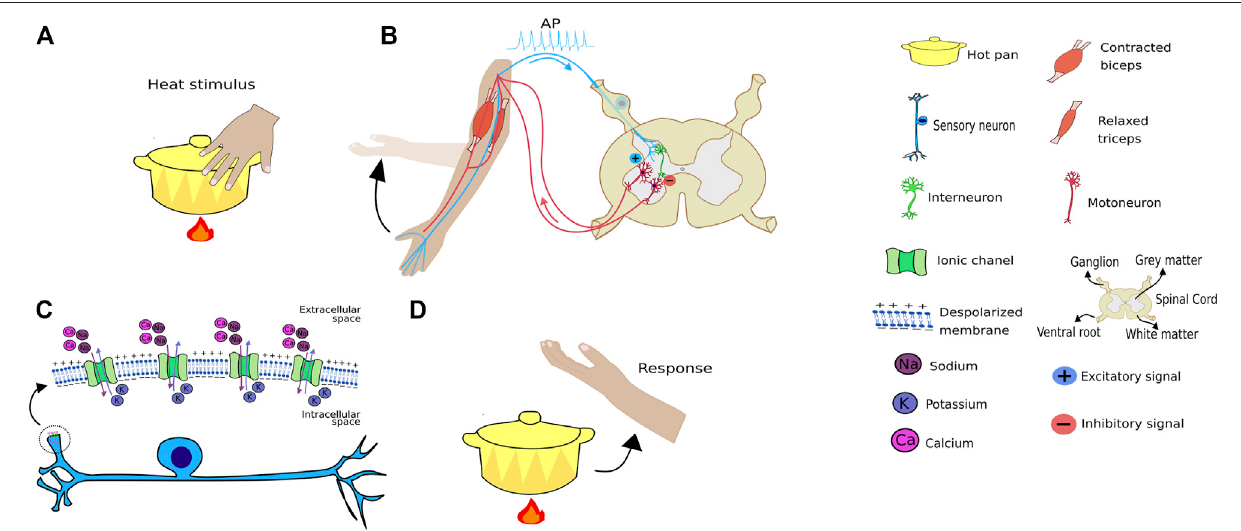
FIGURE2| Heatstimulustransmission. (A) Schematicrepresentationofahandtouchingahotpanandreceivingatemperaturesensoryreceptorstimulus. (B) The stimulus provokes a signal that will travel through a sensory neuron into the spinal cord, releasing excitatory neurotransmissions when it synapses with an alpha motoneuron that innervates the biceps. The sensory neuron will also synapse with an interneuron, that synapses with an alpha motoneuron that innervates the triceps, although in this case inhibitory neurotransmitters are released, causing the triceps to relax, thus, facilitating the withdraw re fl ex. (C) Channels from the TRP family expressedinsensoryneuronswillopenfollowingthethermalstimulus,leadingtoanentranceofcationssuchassodium,resultinginmembranedepolarizationthatcould trigger an action potential. (D) Re fl ex of removing the hand from the heat after touching the pan. It is important to note this movement is performed through the association of inhibitory and excitatory synapses that work as positive and negative weights in arti fi cial neural networks.